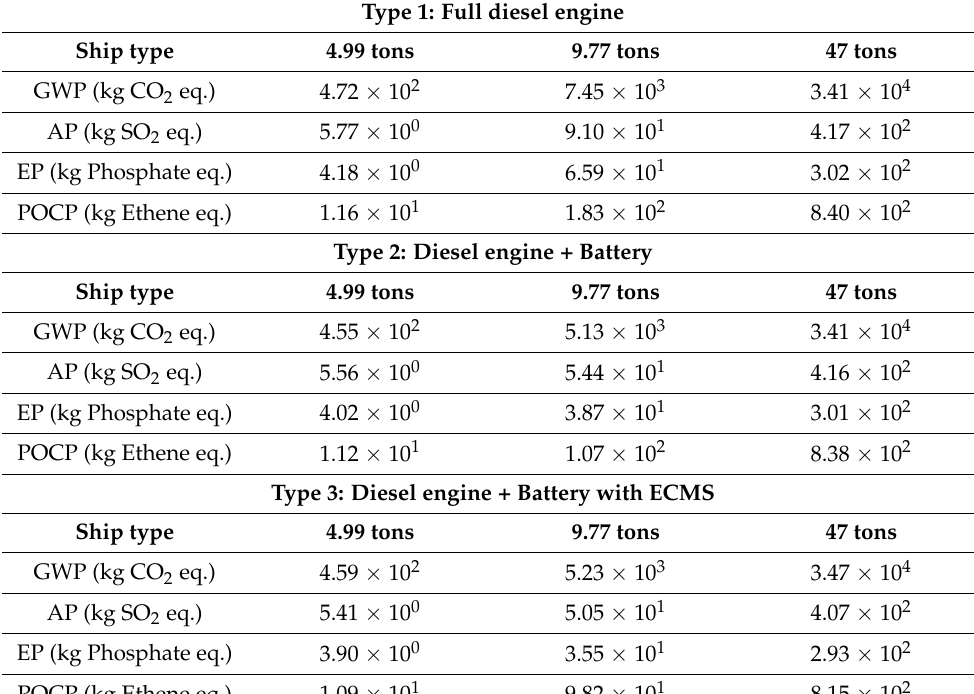
Table 9. Daily emissions from each type of